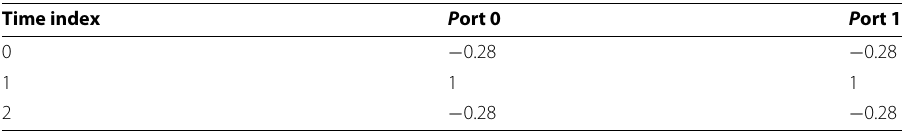
Table 4 Effective CIR on port -0, port